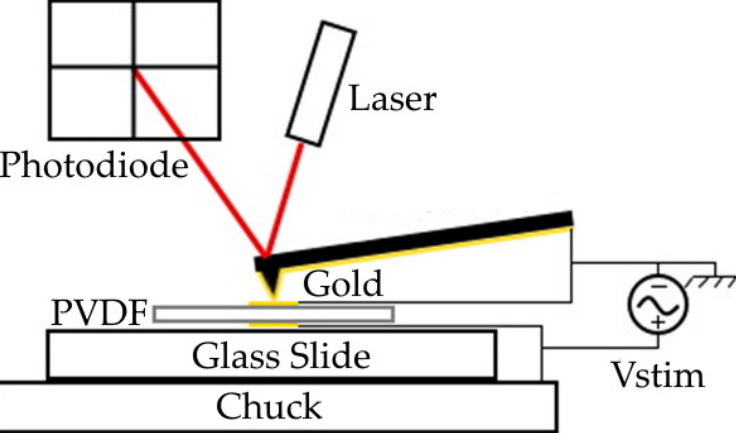
Figure 2. AFM configuration for piezoelectric coefficient measurement.